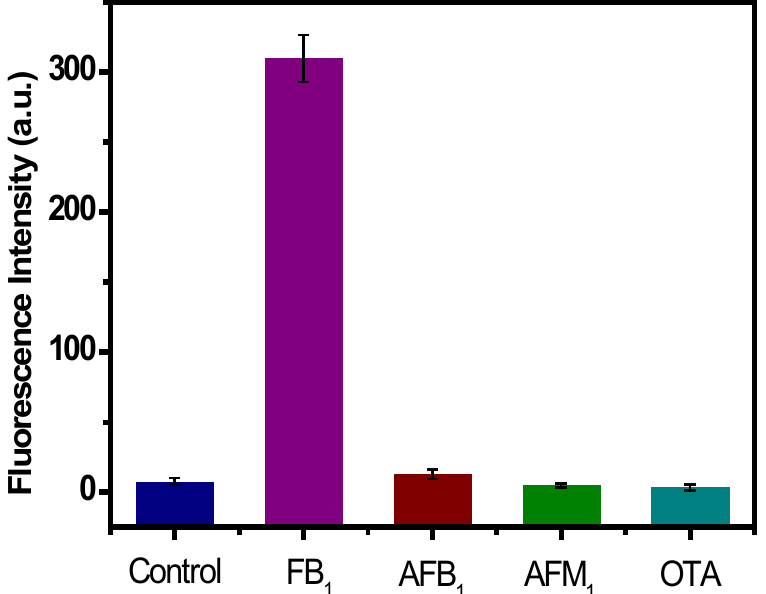
Figure 4. Fluorescence signal response in the absence (control) and presence of mycotoxins at a concentration of 5 ng mL − 1 : FB 1 , AFM 1 , AFB 1 , and OTA. The measurement conditions were as follows: Excitation wavelength ( λ ex) was set at 585 nm, 100 nM FB 1 aptamer, 20 µ g mL − 1 GO, 100 U DNase I. Each data point was the mean of three replicates.